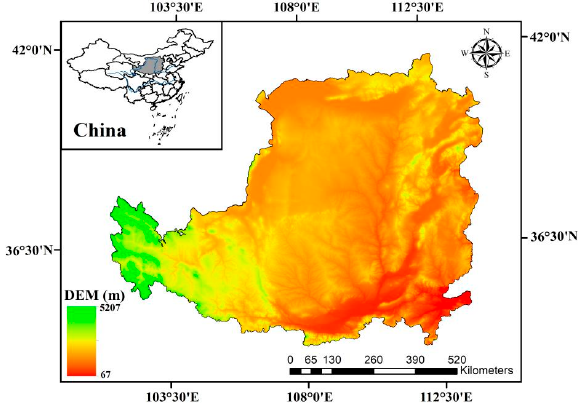
Figure 1. Location of the Loess Plateau.